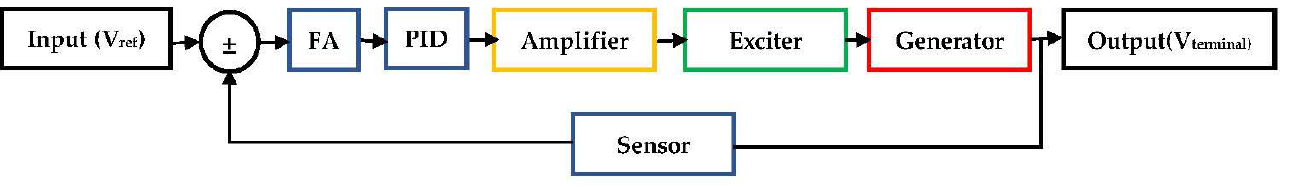
Figure 4. Block diagram of the FAPID-based AVR system. Table 1. An example of fuzzy rules.